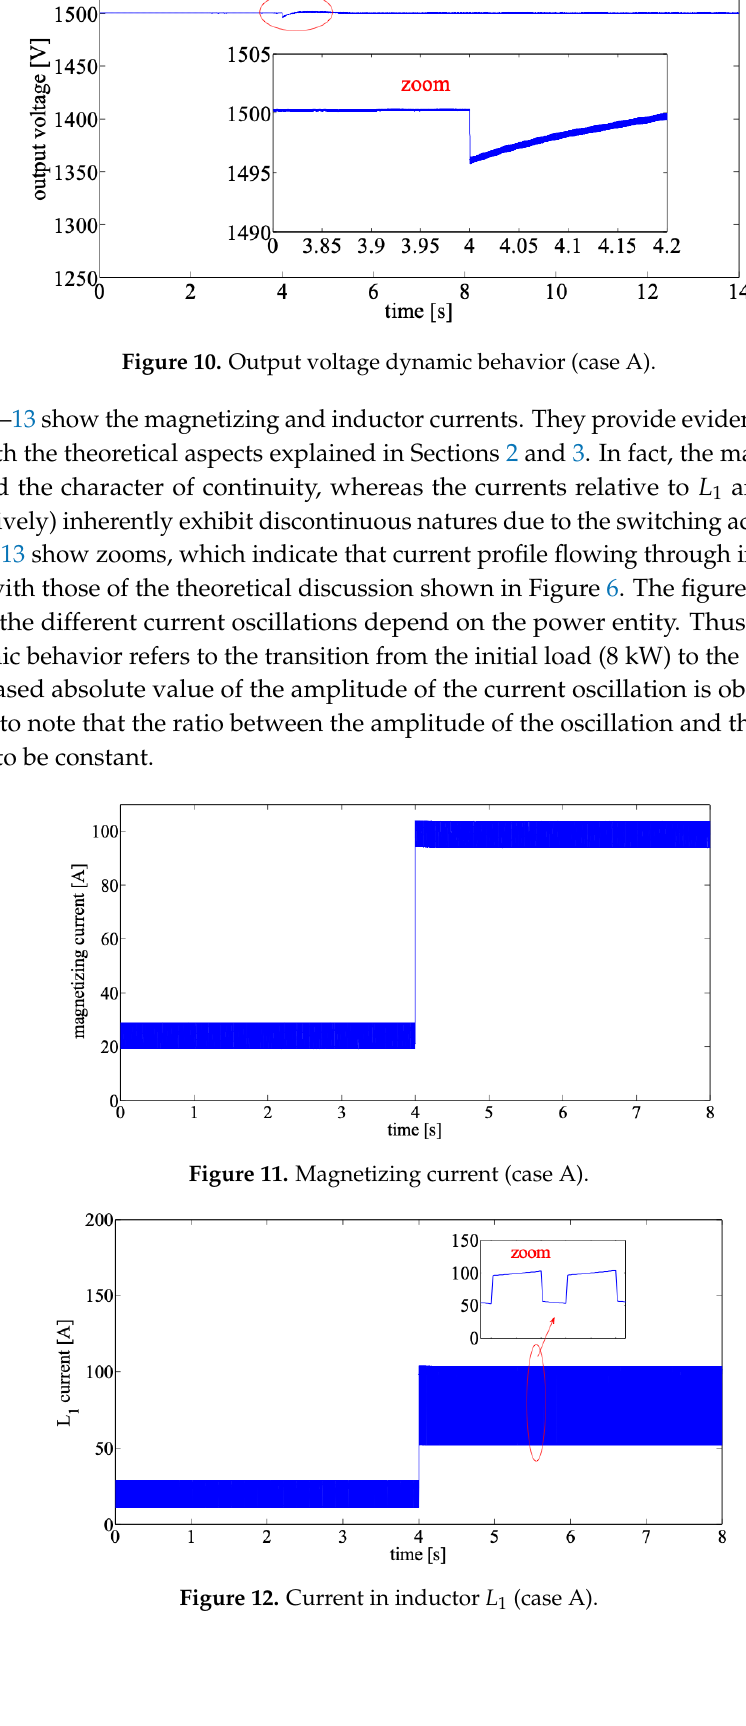
Figure 12. Current in inductor L 1 (case A).